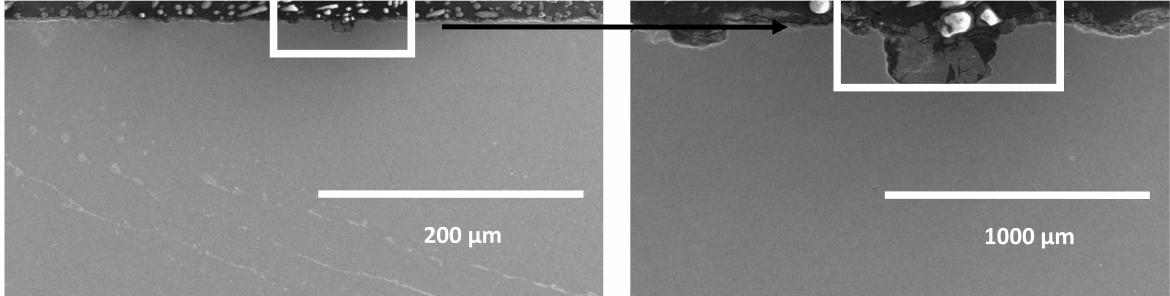
Figure 9. Cross section of L80-1 sample exposed to 80 ◦ C (a long